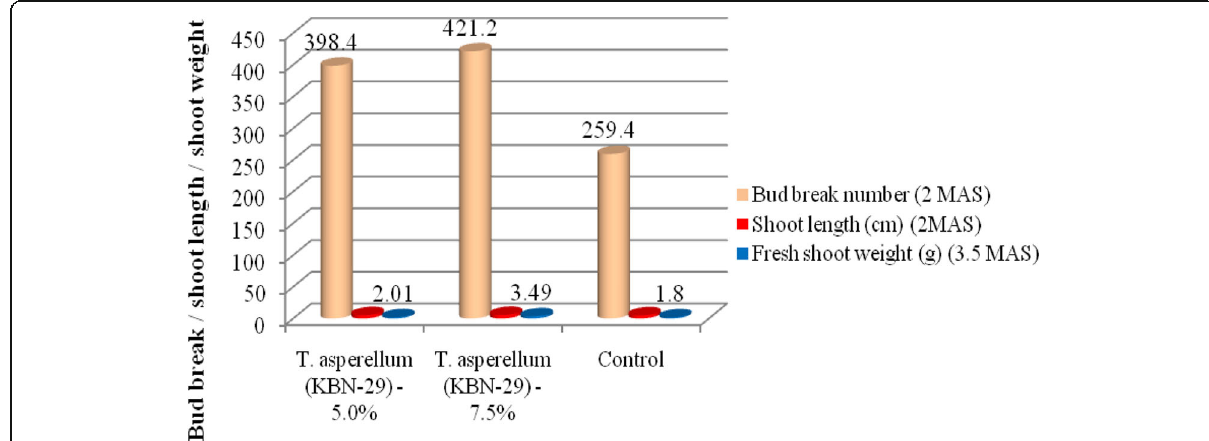
Fig. 3 Comparison of application of concentration of Trichoderma asperellum for light pruned (LP)